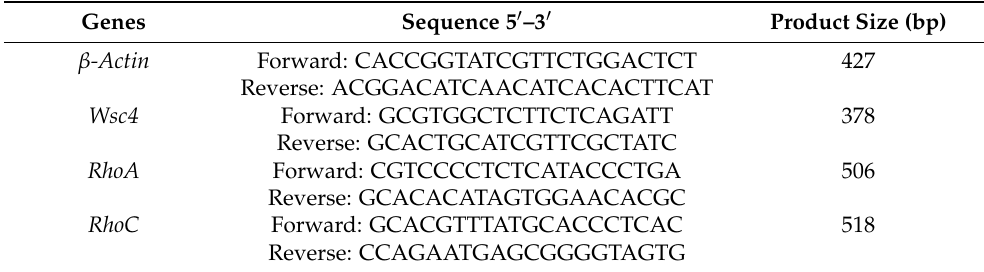
Table 1. Primers designed to detect the expression of four genes associated with cell wall integrity (CWI), germ tube development and growth of Aspergillus niger